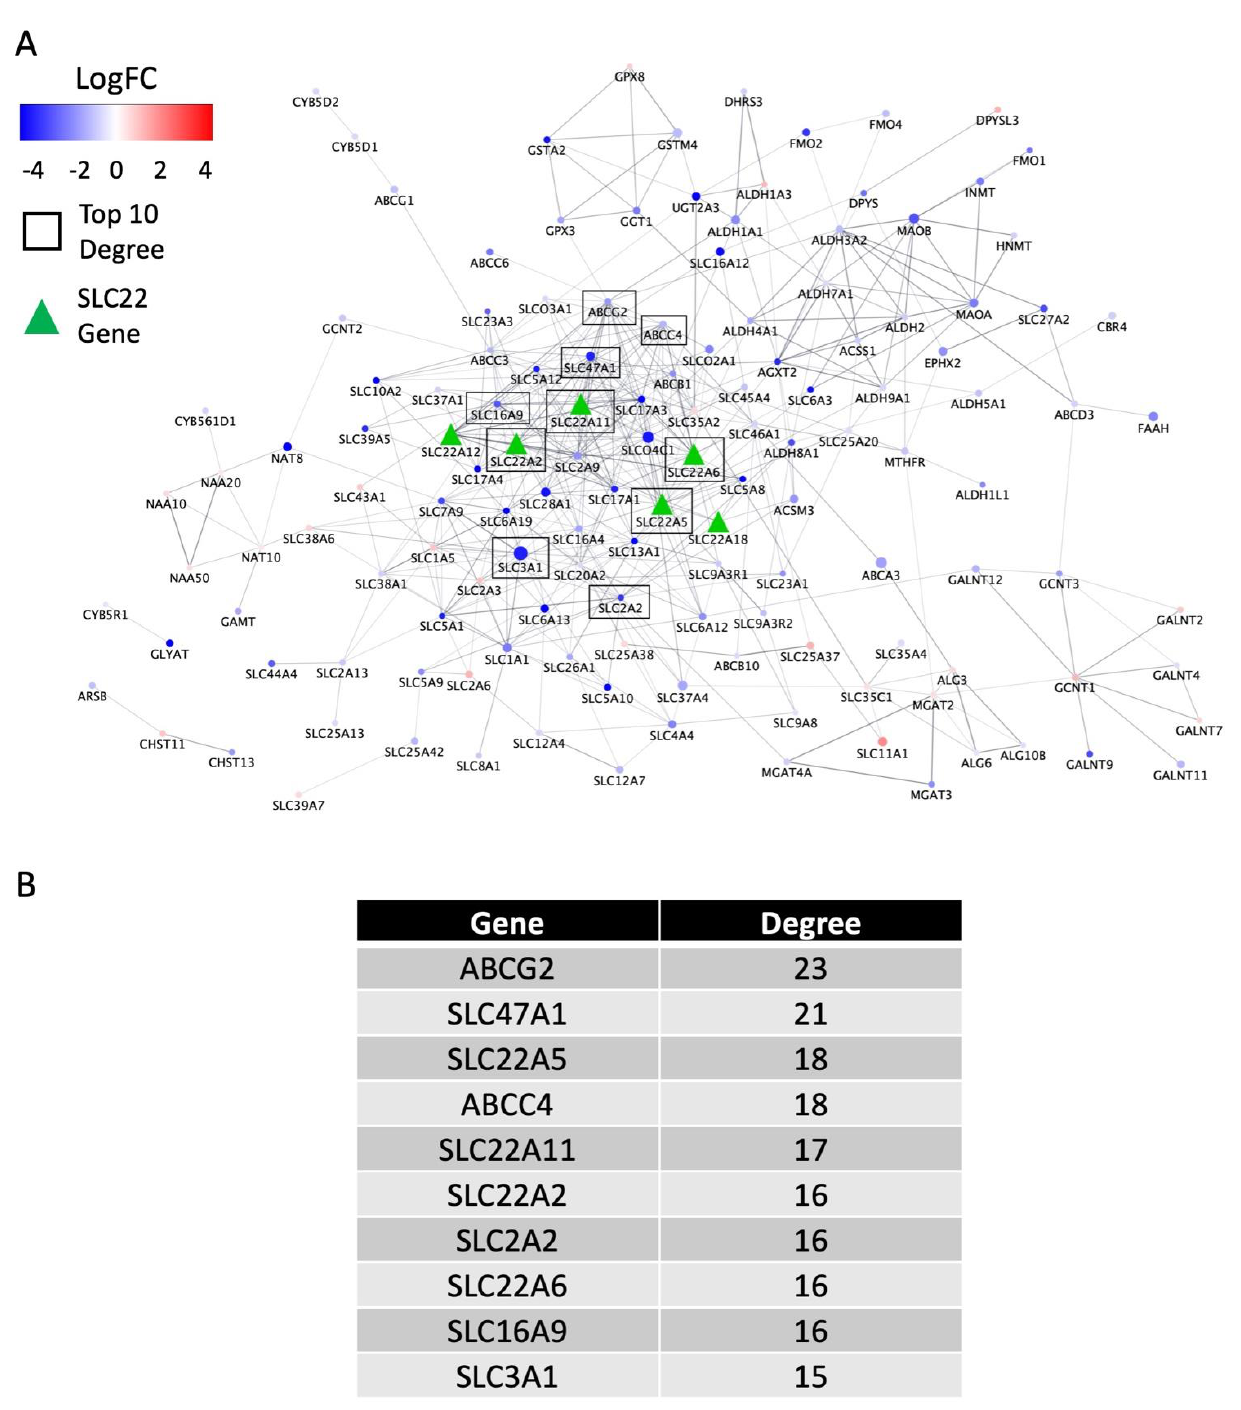
Figure 4. SLC22 gene network and metrics for tumor size/progression class 3 vs. 4 comparison. SLC22 and ADME interaction network composed of DE genes for the comparison of Tumor Size and Progression, T3 vs. T4 ( A ). The 424 Edges represent interactions found in the STRING interaction database and the transparency of the edges is a function of the Combined Score which is also stored in the database. With the exception of SLC22 genes (green triangles), nodes are colored by log fold-change in the relevant comparison and the node sizes correspond to the negative log(adjusted p -value). Nodes with the highest (top 10) degrees are identified within black boxes. ( B ) Table of the top 10 genes by degree identified by black boxes in ( A